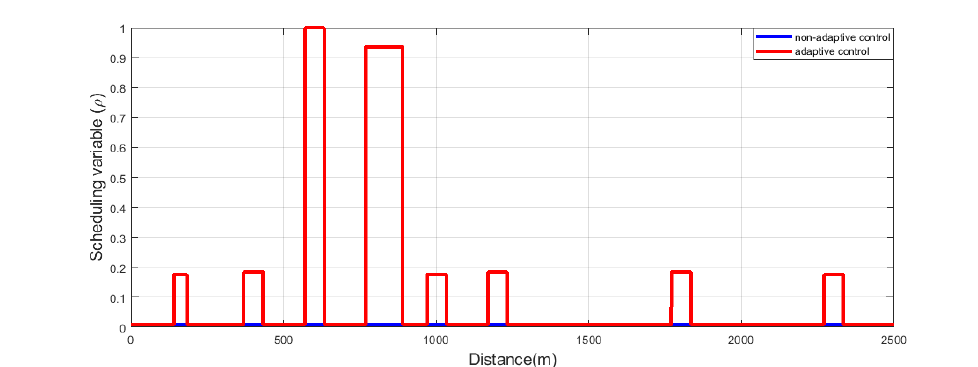
Figure 11. Designed scheduled variable. Table 5. Performance improvement with an adaptive